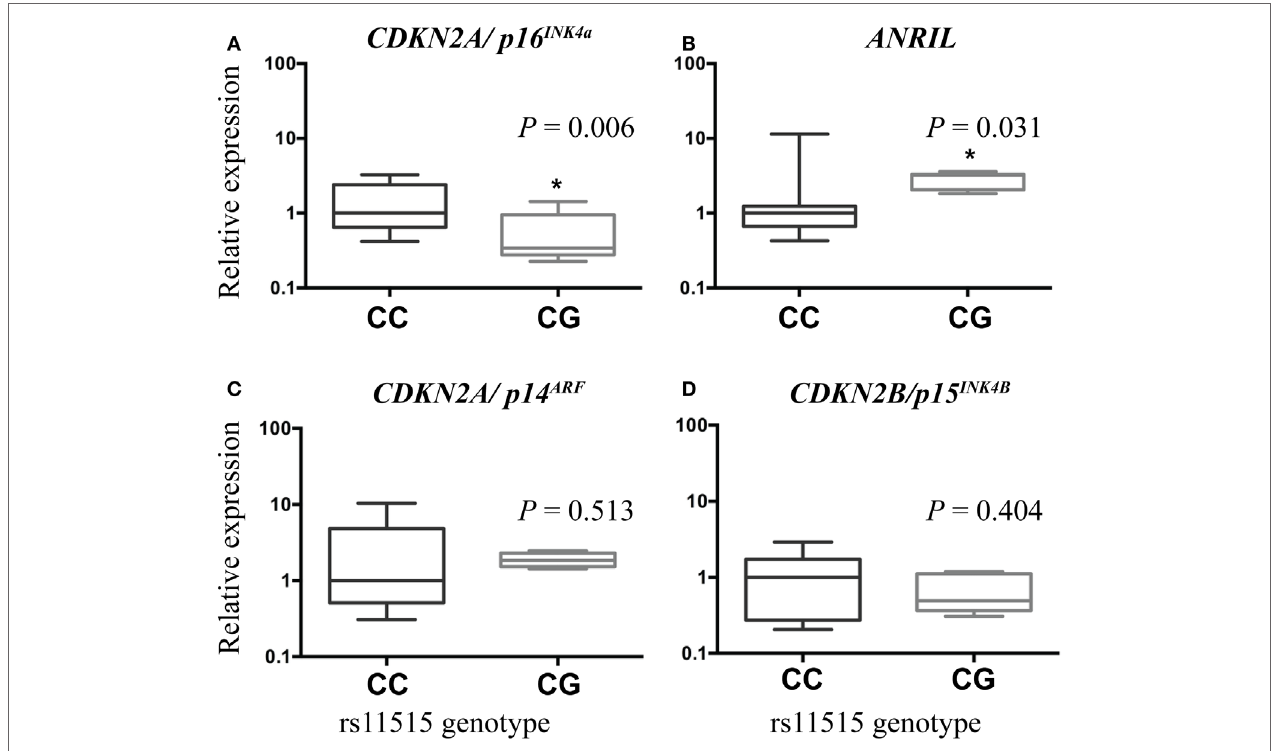
FigUre 1 | Boxplots illustrating associations between gene expression and rs11515 genotypes in breast tumor samples. Compared with tumors with a CC genotype, expression of CDKN2A/p16 INK4a was lower (a) and expression of ANRIL was higher (B) in tumors with a CG genotype. There were no associations between rs11515 genotype and expression levels of CDKN2A/p14 ARF (c) or CDKN2B/p15 INK4b (D) between CG and CC genotypes in breast tumor